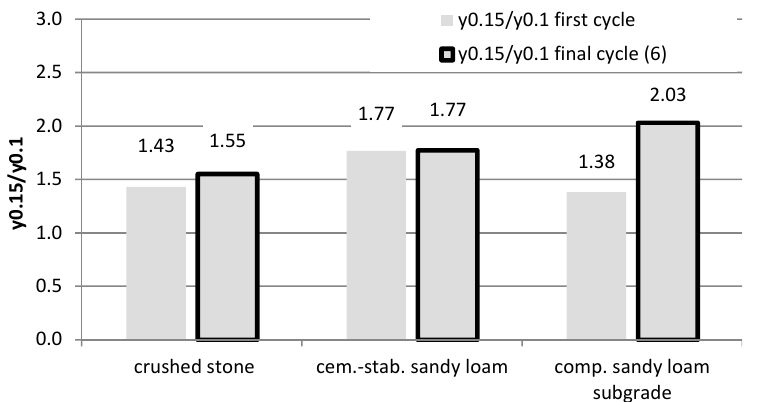
Figure 4. Ratios of displacements obtained in the plate test under the load of 0.15 MPa and 0.1 MPa. The discussed material characteristics, determined on the basis of the displacement values, in relation to the load (for final discharge, which corresponds to a compacted layer system), are shown in Figure 5.